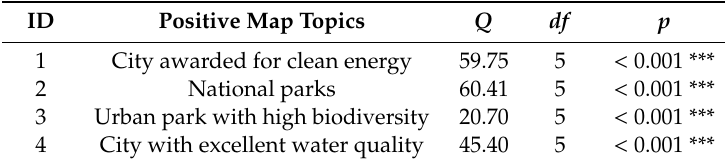
Table 3. Results of Durbin-Skillings-Mack analyses of symbol-content congruence of four positive map topics.